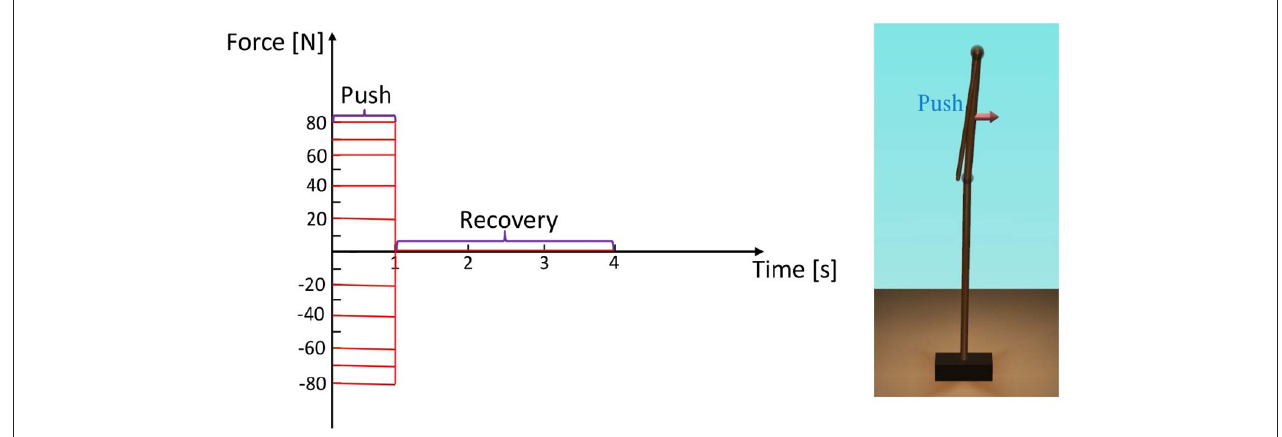
FIGURE 3 | The common simulation settings for the three different arm